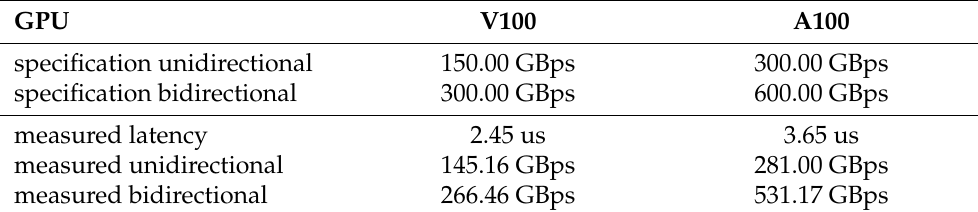
Table 4. P2P data transfer over NVLink interconnect